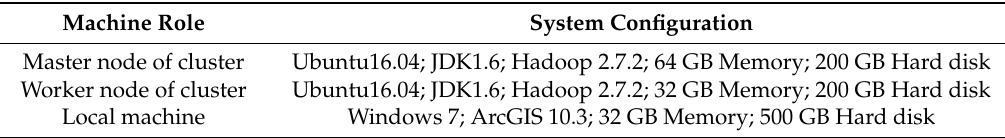
Table 4. The test environment